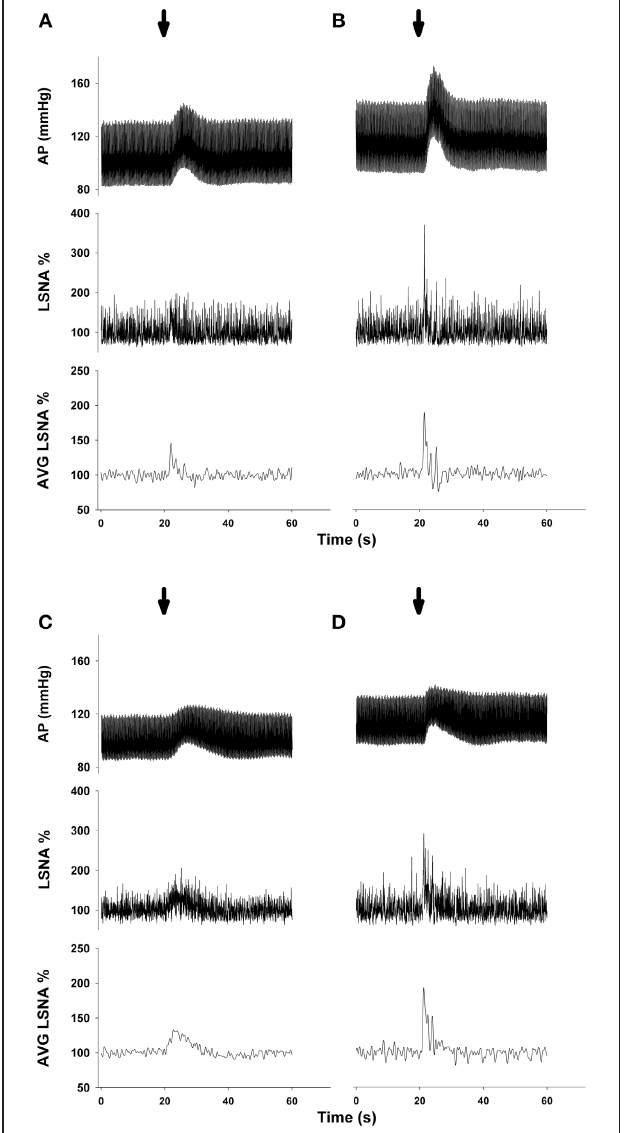
FIGURE 2 | Representative examples of arterial pressure (AP) and LSNA responses to unilateral microinjections of glutamate (30nl, 10mM) into the rostral ventrolateral medulla before and after microinjection of the GABA A antagonist bicuculline (60nl, 5mM). (A) Control response to glutamate in one sedentary rat. (B) Response to glutamate in the same sedentary rat 5min after bicuculline. (C) Control response to glutamate in one physically active rat. (D) Response to glutamate in the same physically active rat 5min after bicuculline. Note enhanced pressor response only in sedentary rat after bicuculline and enhanced LSNA response in both sedentary and physically active rats following bicuculline. Arrow represents timing of glutamate microinjection. Abbreviations are as defined in Figure 1 .